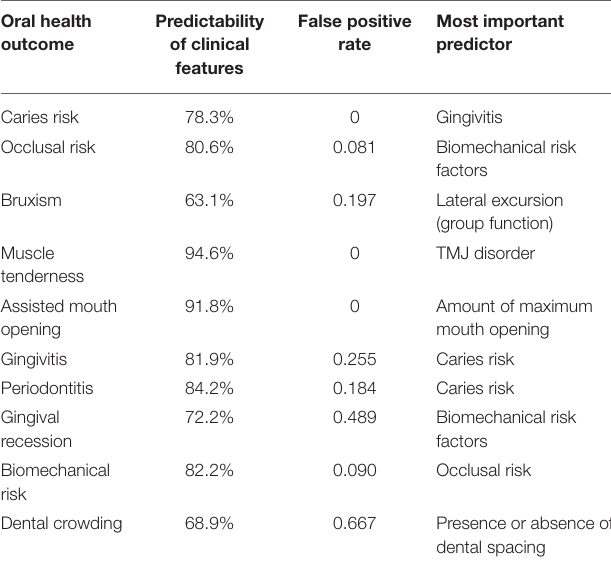
TABLE 2 | Variables with significant predictability for different oral health outcomes according to ordinal logistic regression analysis results.